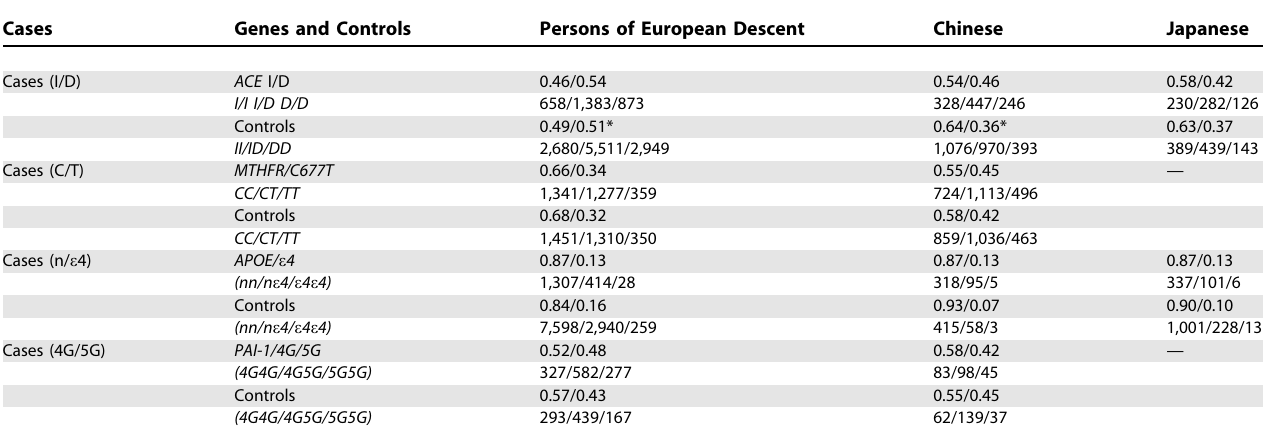
Table 4. Allele and Genotype Frequencies by